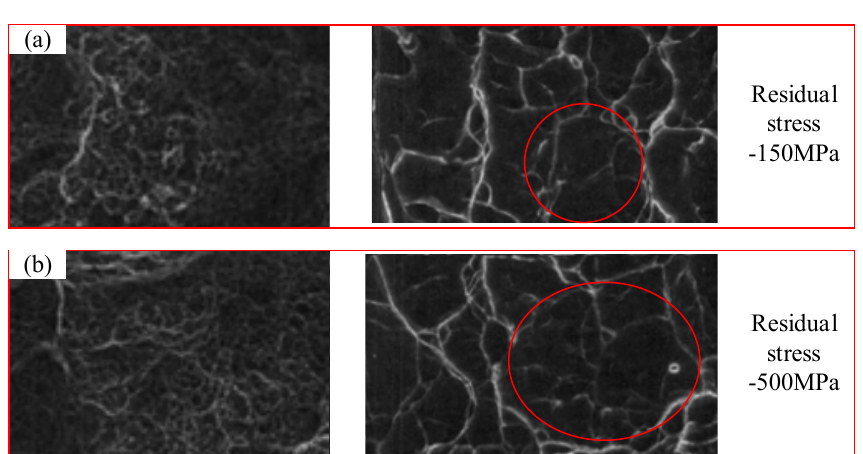
Figure 14. Fatigue crack growth.